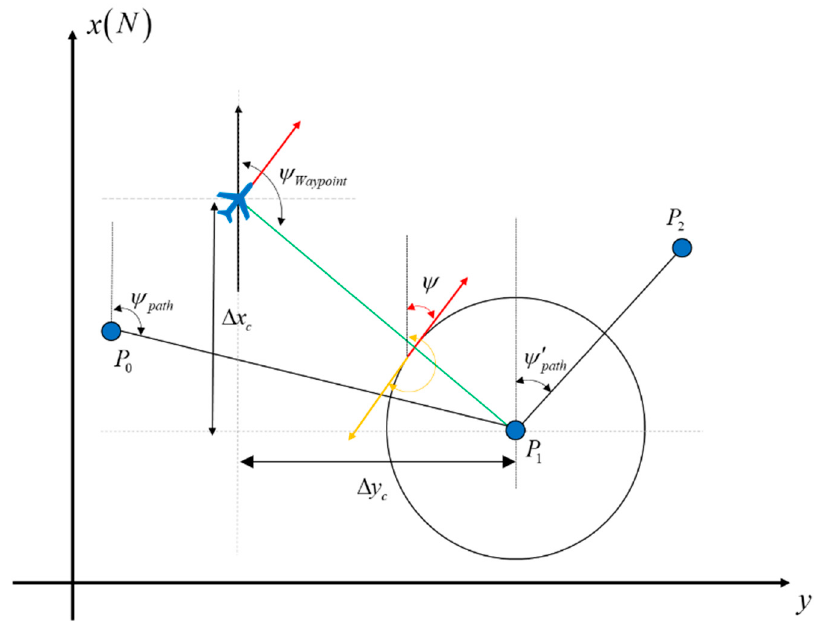
Figure 8. Hover guidance.